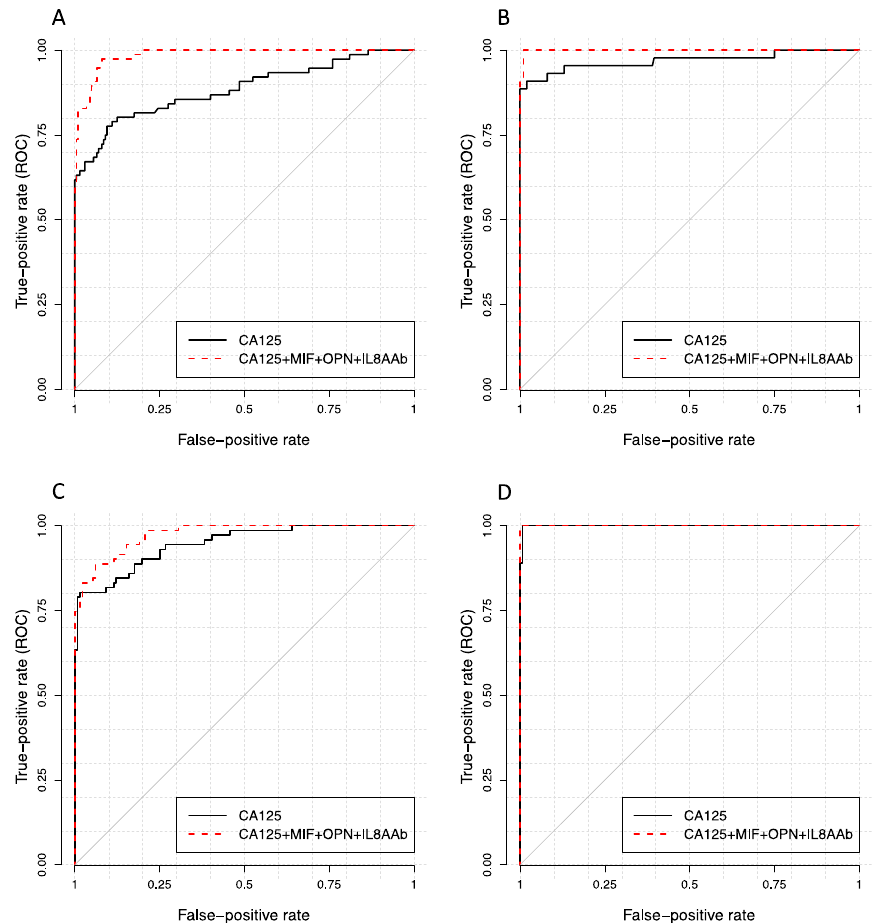
Figure 3. Receiver operating characteristic (ROC) curves for a combination of CA125, OPN, MIF and anti-IL-8 autoantibody biomarkers. ( A ) Early stage cases of discovery set. ( B ) Late stage cases of discoveryset. ( C )Earlystagecasesofvalidationset. ( D )Latestagecasesofvalidationset. Acombination of CA125, OPN, MIF and IL-8 AAb levels had a significantly greater AUC (0.985) than did CA125 alone in early stage cases of discovery set (AUC = 0.885, p < 0.001). Compare to CA125 alone (AUC =